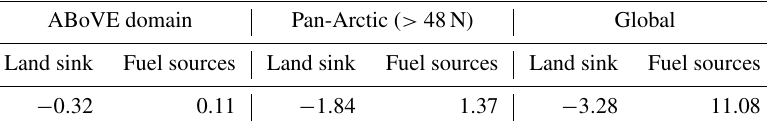
Table 2. GEOS CO 2 flux estimates (PgCyr − 1 ) for 2017. Flux emissions are specified for (a) the natural land sink component, which includes the sum of NEE and biomass burning, and (b) all anthropogenic source components, which include fossil fuel and biofuel